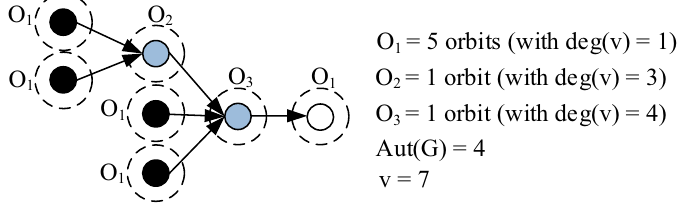
Figure 2. Parametrization of the selected graph from the viewpoint of symmetry quantification using